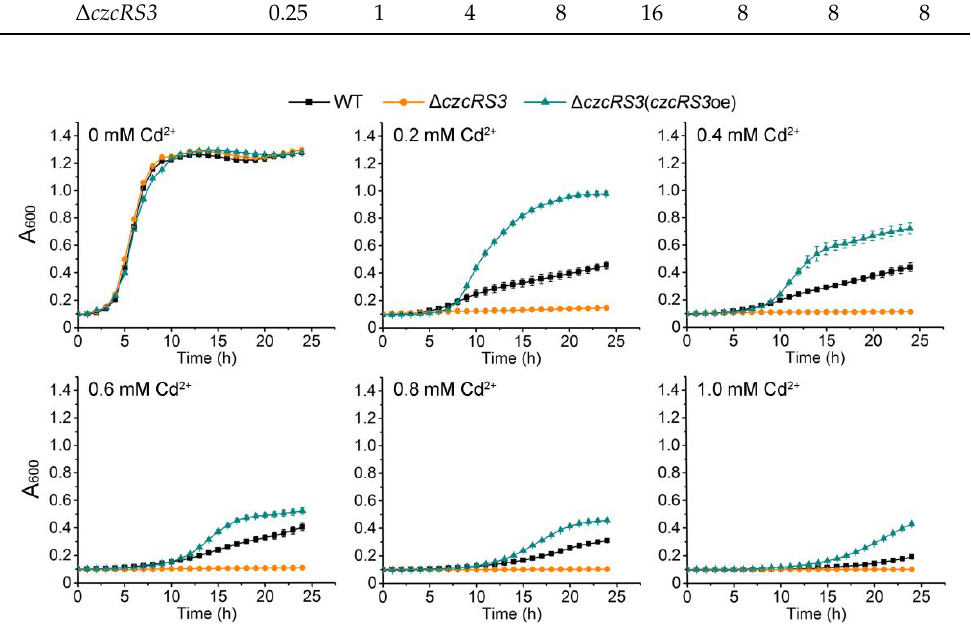
Figure 1. The role of czcRS3 in Pseudomonas putida cadmium resistance. The wild-type P. putida KT2440 (WT, black), deletion Δ czcRS3 (orange), and overexpressed Δ czcRS3 ( czcRS 3oe) (blue, harboring pB403- czcRS3 ) cells were incubated in LB medium supplemented with CdCl 2 at concentrations ranging from 0 to 1 mM. The absorbance at 600 nm (A 600 ) was measured to evaluate the bacterial growth under cadmium stress. The data represent the mean ± standard deviation of three replicates.